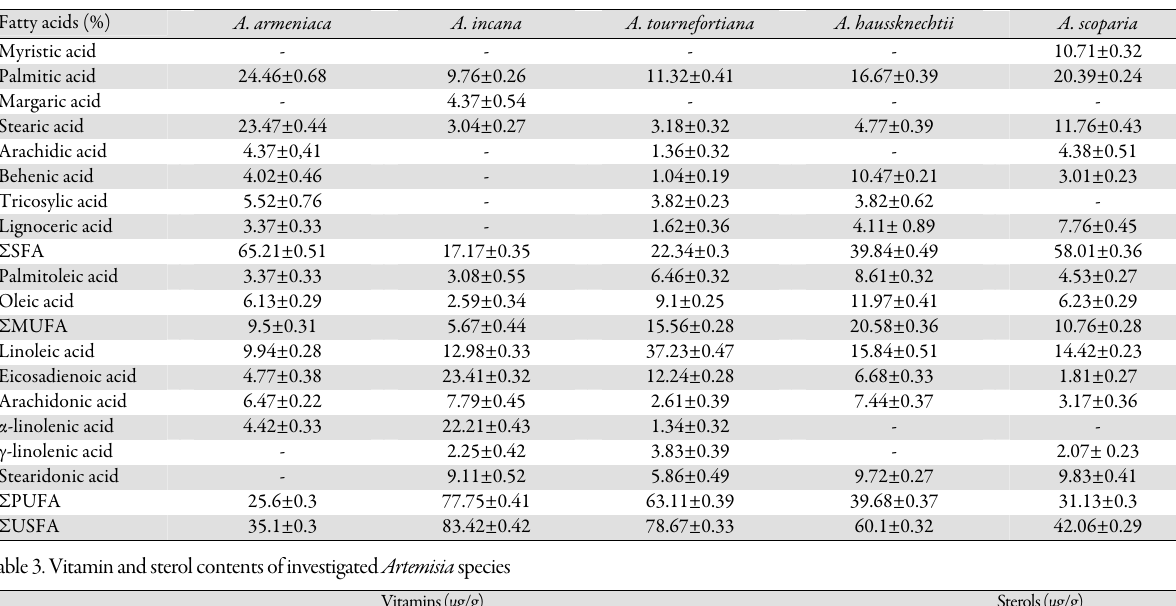
Table 2. Fatty acid compositions (%) of investigated Artemisia species SFA: Saturated fatty acids MUFA: Monounsaturated fatty acids PUFA: Polyunsaturated fatty acids USFA: Unsaturated fatty acids Fatty acids (%) Palmitic acid